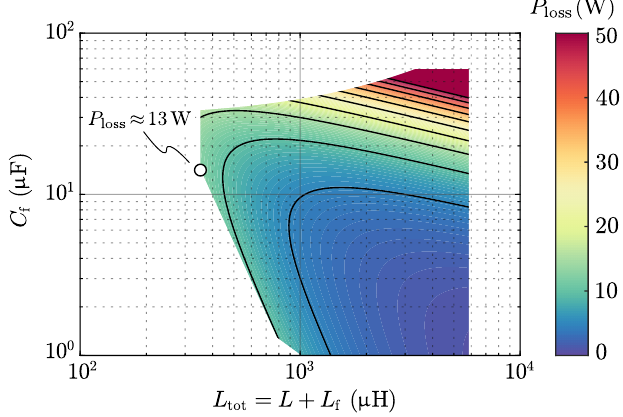
Figure 11. Resistive damping loss as function of L tot and C f